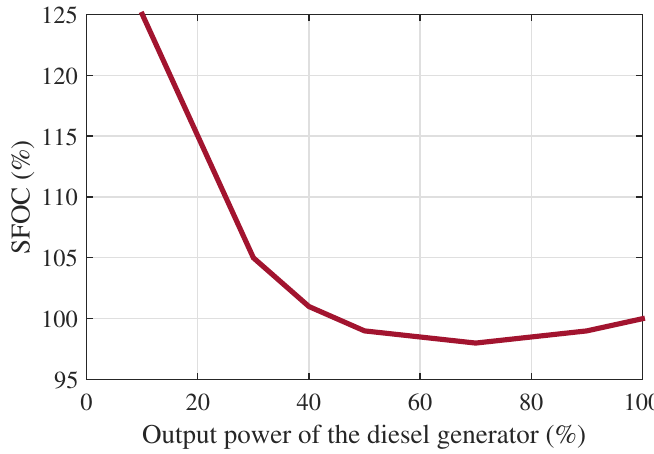
Figure 4. The SFOC curve for a diesel generator